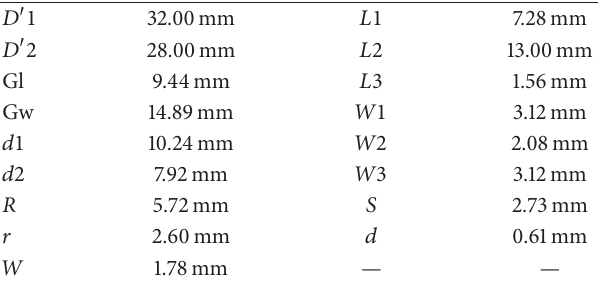
Table 2: Cactus antenna dimensions. Table 3: Miniaturized cactus antenna